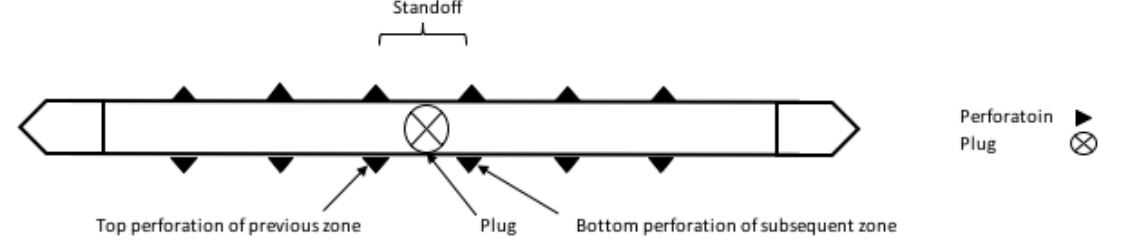
Figure 2. Perforation standoff between top perforation of previous stage and bottom perforation of subsequent stage .